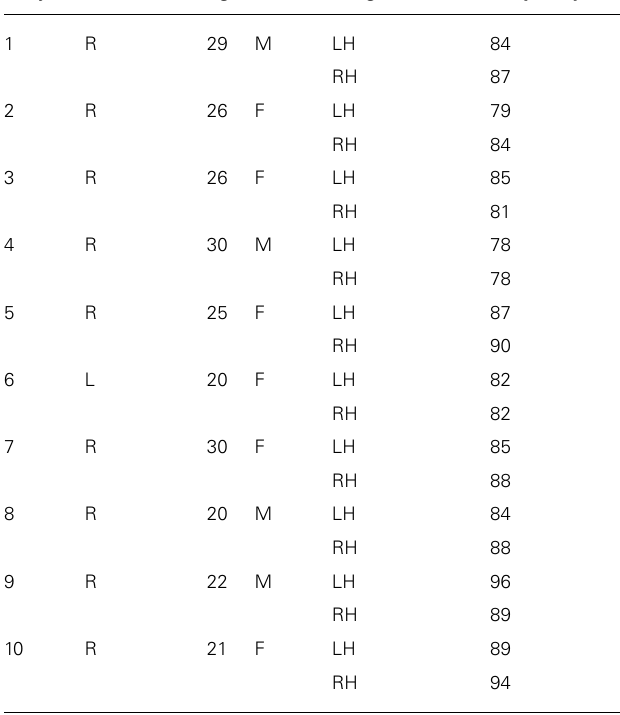
Table 1 | Peak HG frequencies between cue onset and 1 s post-cue onset during left hand (LH) and right hand (RH) motor imagery EEG sessions.